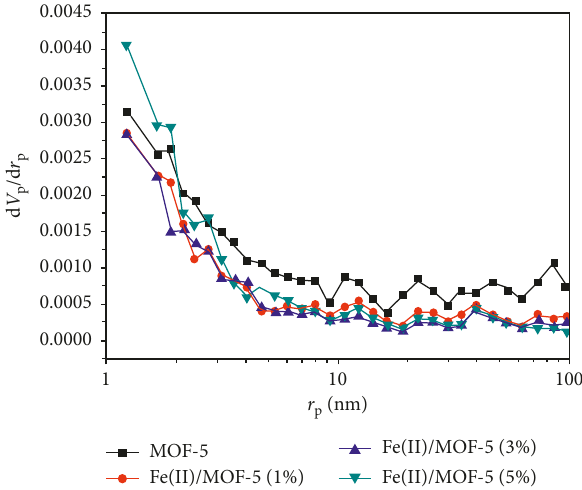
Figure 7: Pore size distribution of the